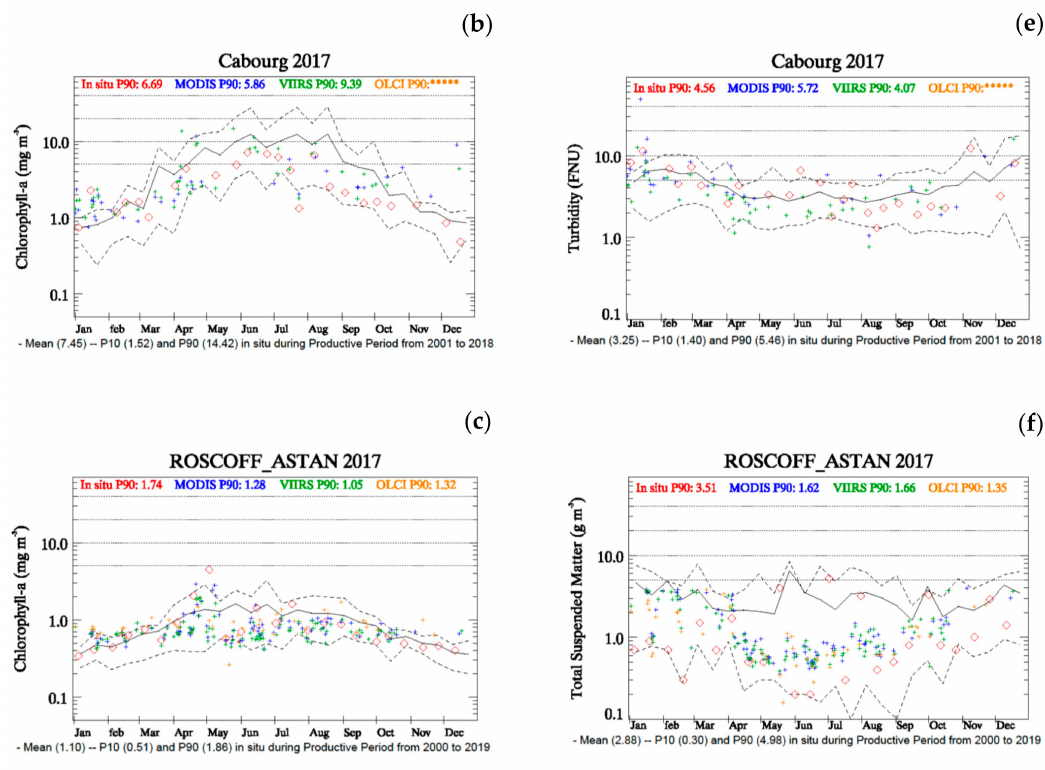
Figure 6. Chl- a ( a – c ), Turbidity ( d , e ) or TSM ( f ) in the Bay of Seine (Antifer and Cabourg) and in the western English Channel (Rosco ff Astan). In situ and satellite percentiles of year 2017 are indicated in the upper part of the graphs; the in situ historical mean, P10 and P90, calculated over the productive period, are indicated under the time axis.